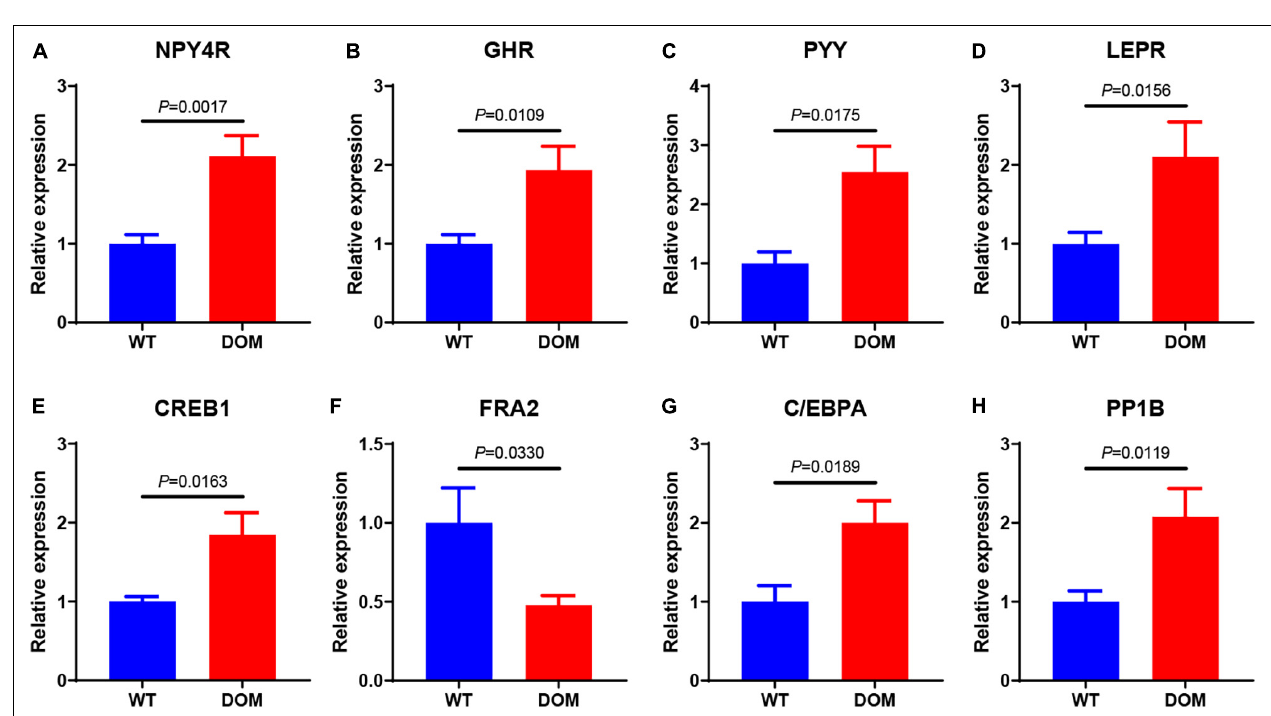
FIGURE 1 | Feed domestication improves growth performance and digestive enzyme activity in A. grunniens . Panels (A–D) represent the growth performance, panel (E) represents the glucose content in the plasma, and panels (F–H) represent the digestive enzyme activity in the intestine. (A) Final body weight, FBW; (B) Condition factor, CF; (C) Viscerosomatic index, VSI; (D) Hepatosomatic index, HSI; (E) Glucose; (F) Amylase; (G) Lipase; and (H) Trypsin. Data were analyzed by Student’s t -test, and results were indicated as mean ± SEM; (A–D) n = 27; (E–H) n = 9.